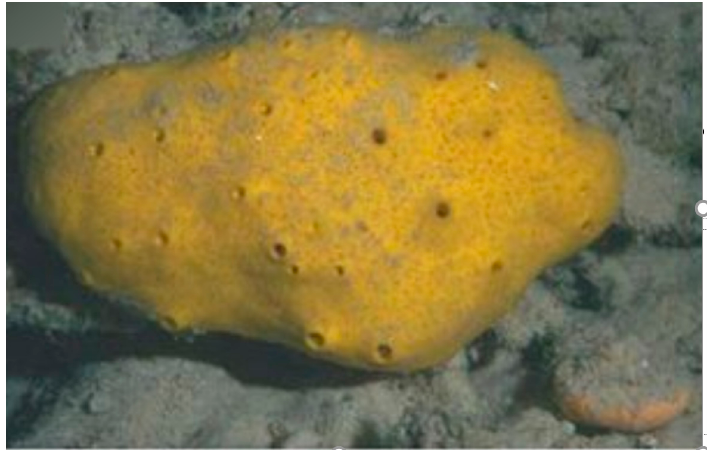
Figure 16. Specimen of Petrosia alfiani demosponge